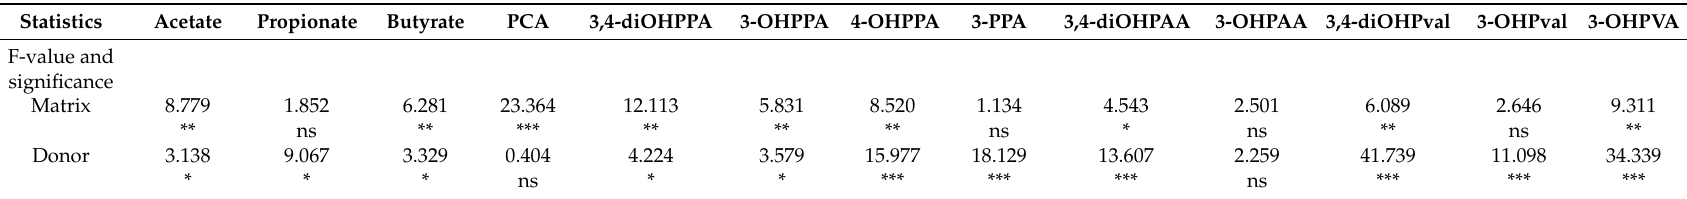
Table 3. Statistical analysis of the effect of matrix and donor on the production of microbial metabolites (SCFAs and phenolics) and degradation of procyanidin during in vitro fermentation of the apple matrices with fecal microbiota ( n = 3) from four healthy donors 1